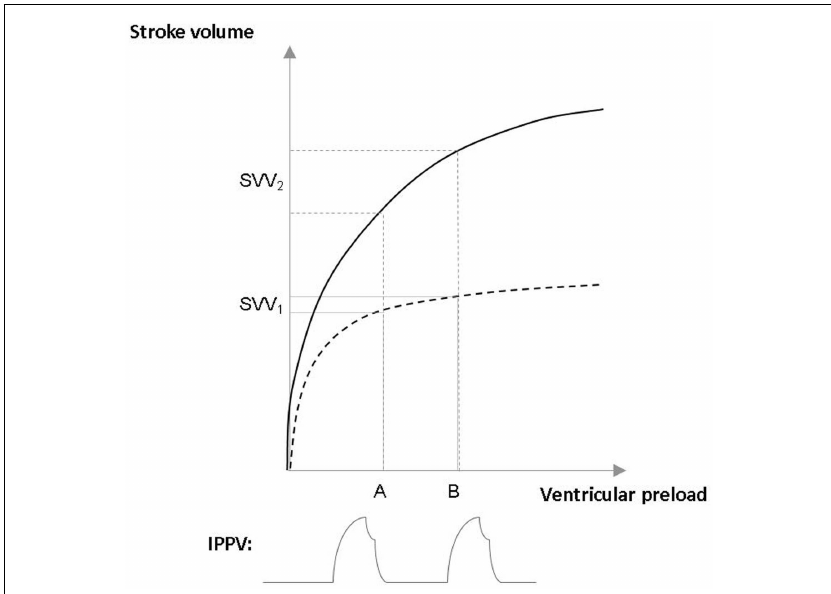
FIGURE 1 |Assessing fluid responsiveness with stroke volume variation (SVV) in patients with different Frank–Starling curves .The upper curve (——) represents the Frank–Starling curve of a patient with normal heart, the lower curve ( – – – ) a patient with chronic heart failure. Intermittent positive pressure ventilation (IPPV) causes a similar changes in ventricular preload (A–B) in both cases. However, in the patient who is on the flat part on the Frank–Starling curve IPPV causes small stroke volume variation